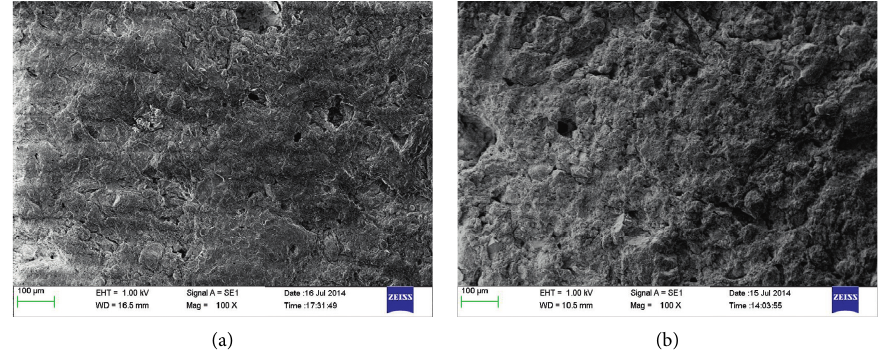
Figure 1: SEM graphs of sample. (a) Sintering shale sample. (b) Sintering shale sample with 6% sawdust.